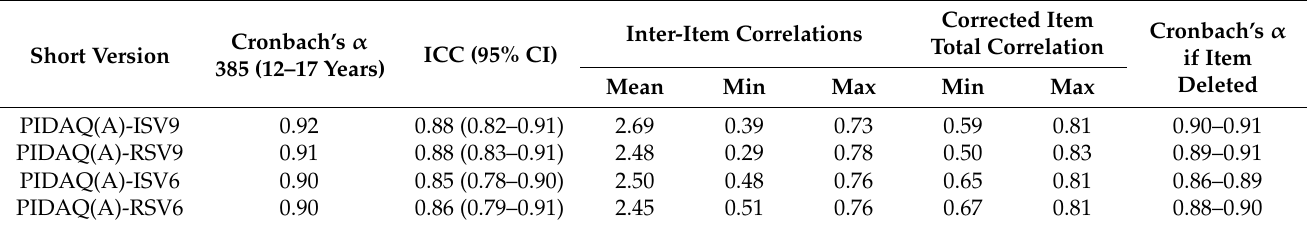
Table 6. The internal consistency, scale statistics, and inter-item correlations of all short versions of the Arabic PIDAQ (n = 385).